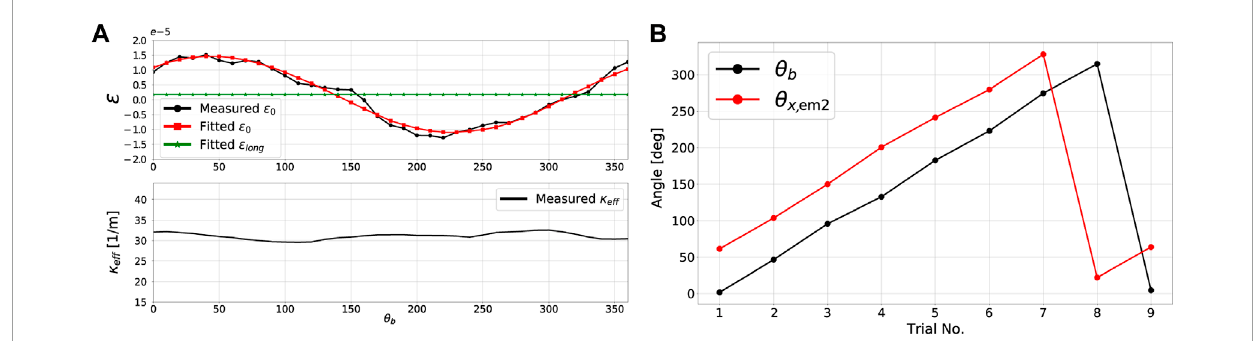
FIGURE 6 Catheter tip force sensor calibration results: (A) central core strain and curvature profiles during the identification of d r and θ r , and (B) θ b and θ x 2 profiles for different force sensor rotational configurations about its longitudinal